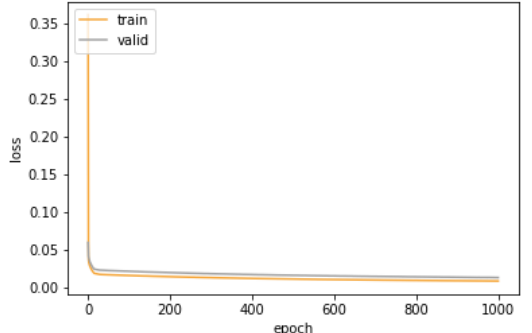
Figure 6. Convergence of the loss in 1000 epochs (ImageNet